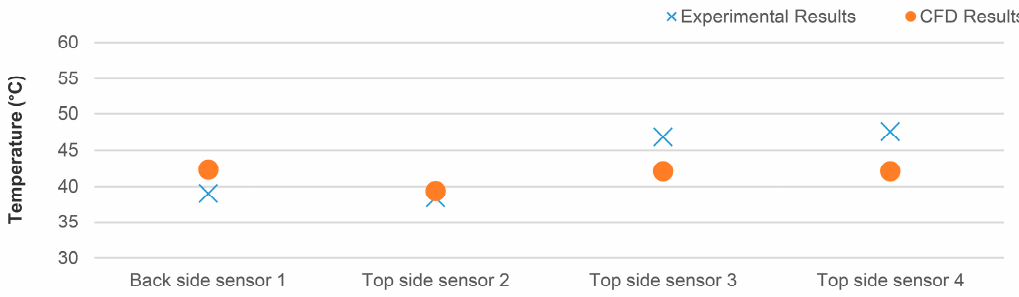
Figure 14. Measurement A: experimental results versus Computational Fluid Dynamics (CFD) results .